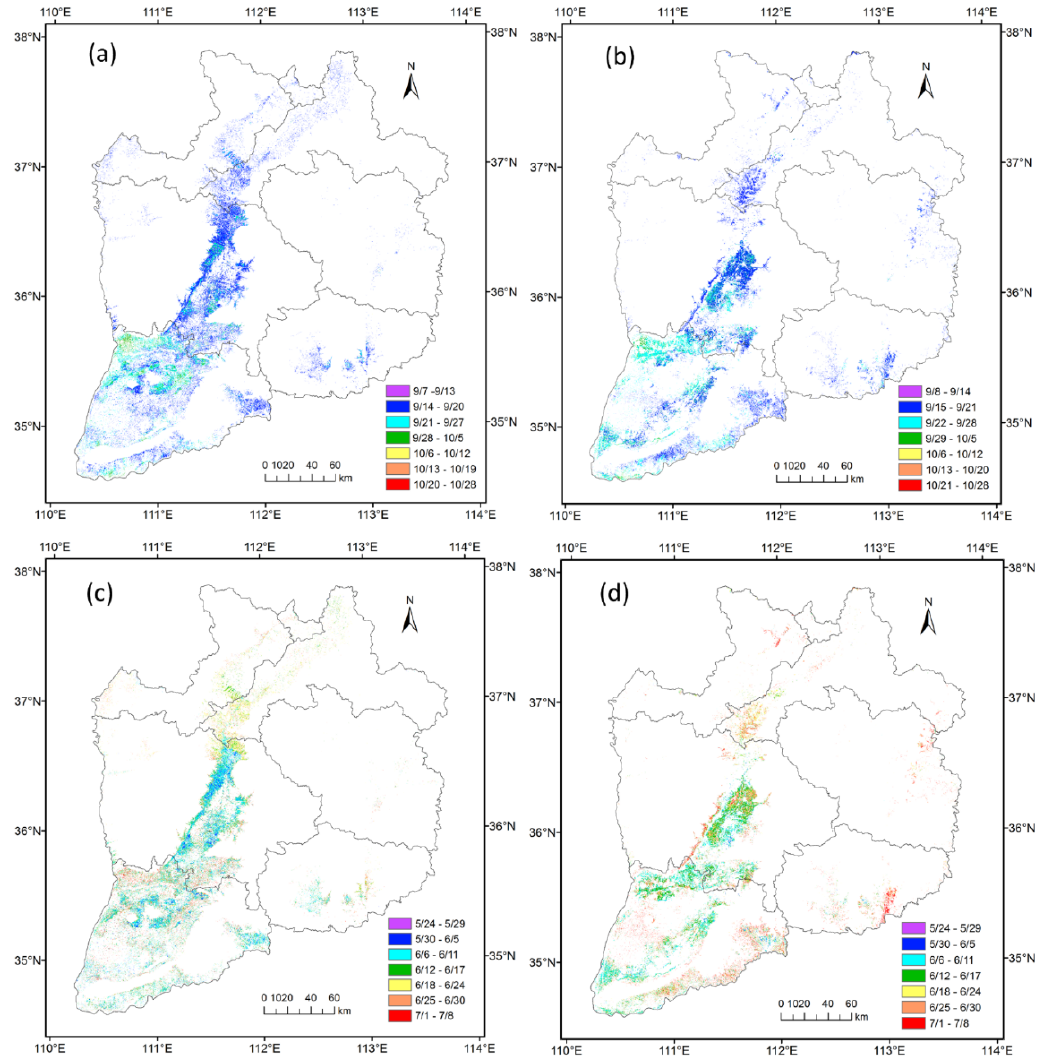
Figure 8. Sowing dates of rainfed ( a ) and irrigated ( b ) wheat. Maturity dates of rainfed ( c ) and irrigated ( d ) wheat in south central Shanxi Province.